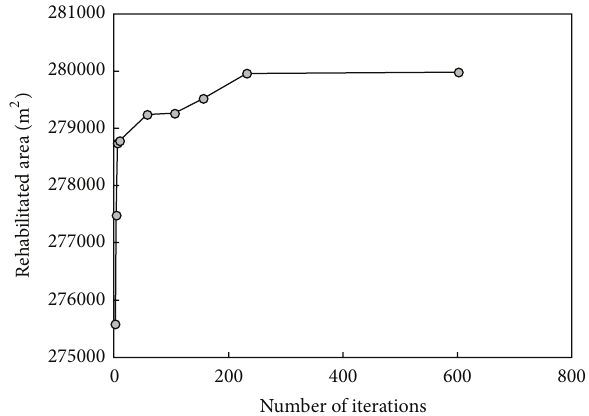
Figure 4: Rehabilitated area as a function of the number of itera-